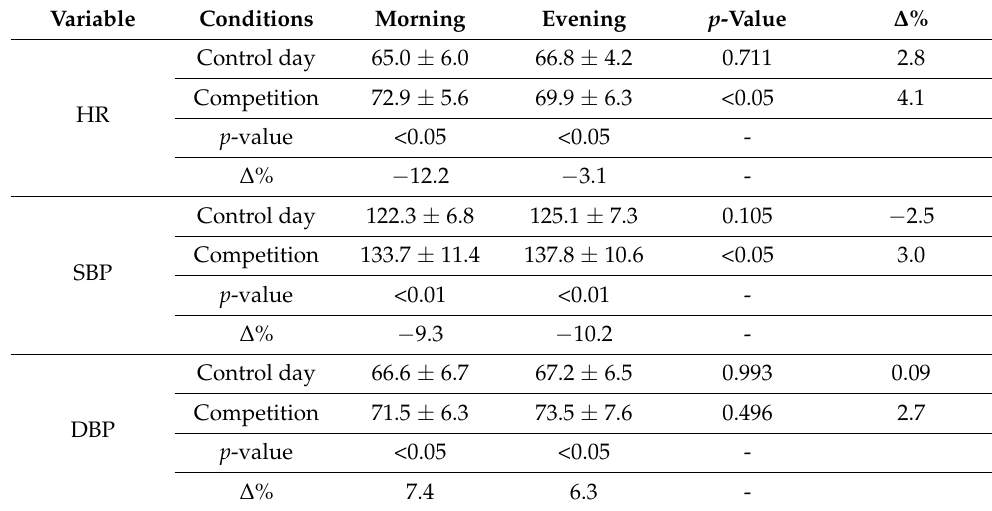
Table 2. Descriptive statistics of heart rate (HR), systolic blood pressure (SBP), and diastolic blood pressure (DBP) and the respective differences between